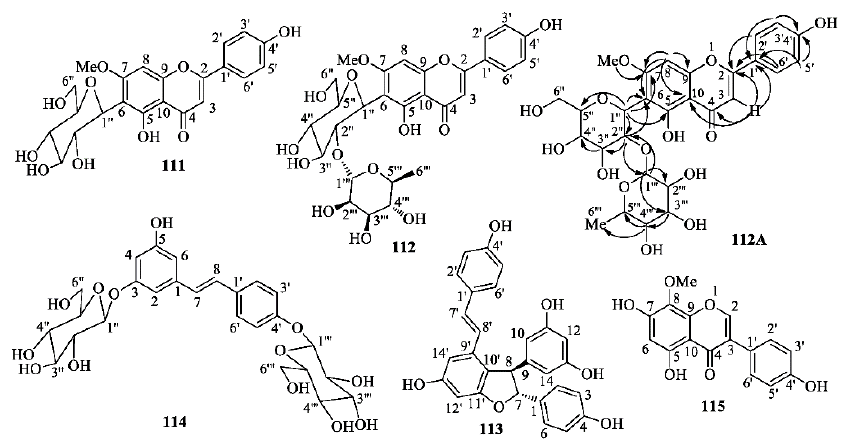
Figure 10. Structures of swertisin ( 111 ), 2 ′′ - O -rhamnosyl swertisin ( 112 ), viniferin ( 113 ), resveratrol 3,4 ′ - O -di- β - D -glucopyranoside ( 114 ), isotectorigenin ( 115 ) isolated from Iris postii Mouterde; H → C HMBC correlations determined in the 2D-NMR spectrum of 2 ′′ - O -rhamnosyl swertisin ( 112A ).